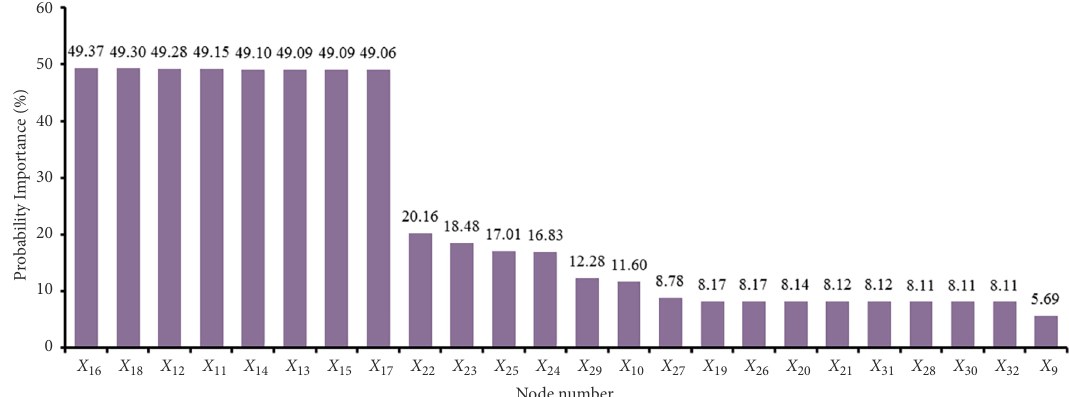
Figure 13. Sequencing results of Probability Importance of nodes X 9 to X 32